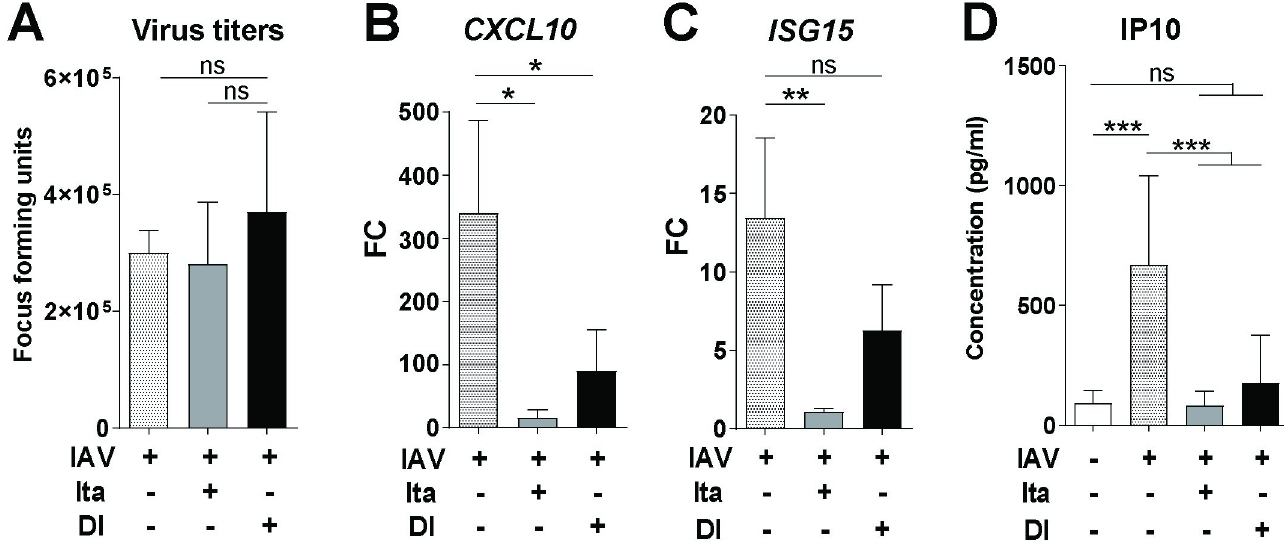
Fig 7. Anti-inflammatory effect of itaconate and DI on IAV-infected human lung tissue explants. Human primary lung tissue from patients with emphysema and pulmonary arterial hypertension was incubated overnight with itaconate (25 mM), DI (1 mM), or medium only and was then infected with IAV (PR8M, 2x10 5 FFU/ml) for 24 h. A . Viral titers in supernatant (focus forming assay). B-D . CXCL10 mRNA ( B ), and ISG15 ( C ) mRNA in tissue (RT-qPCR); IP10 concentration in supernatant (EIA) ( D ). Mean ± SEM (n = 6 donors, 3 tissue pieces per replicate). Reference for fold change = uninfected 24 h. � p < 0.05; �� p < 0.01; ��� p < 0.001 (Mann-Whitney U